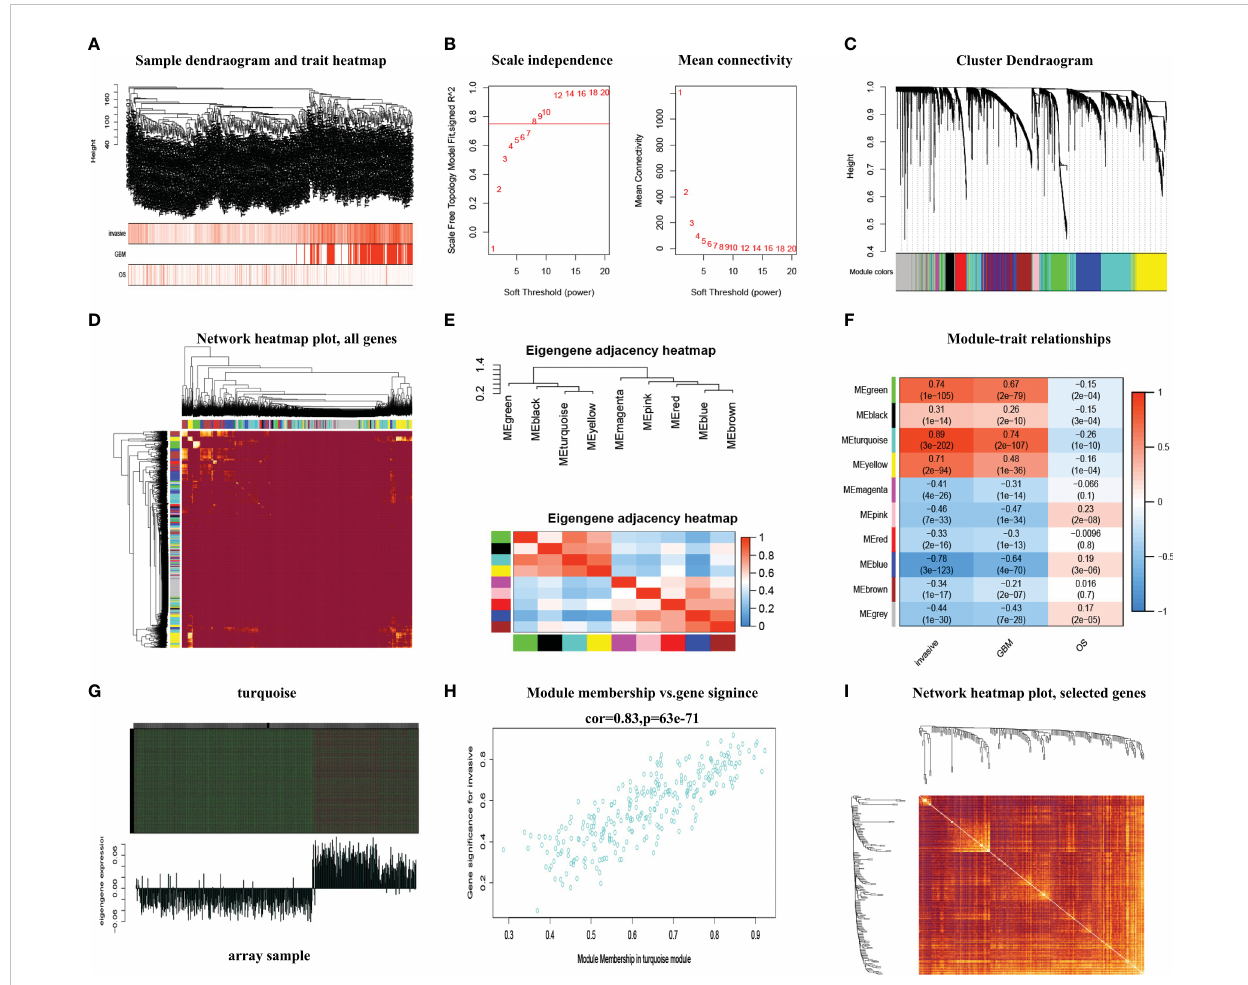
FIGURE 1 The WGCNA method was used to screen the hub genes. (A) Mapping of clinical trait variables and aggregation trees. (B) The soft thresholding and correlation coef fi cient. (C) The dynamic tree was constructed. (D) A TOM plot of genes in each module. (E) The eigengene adjacency heatmap. (F) Correlation between module eigengenes and GBM and overall survival rate. (G) Gene expression of the turquoise module with the feature vector of that module. (H) The scatter plots of module membership (MM) in the turquoise module versus gene signi fi cance (GS) of in fi ltration. (I) The TOM plot displays the topological relationship between different genes in the turquoise